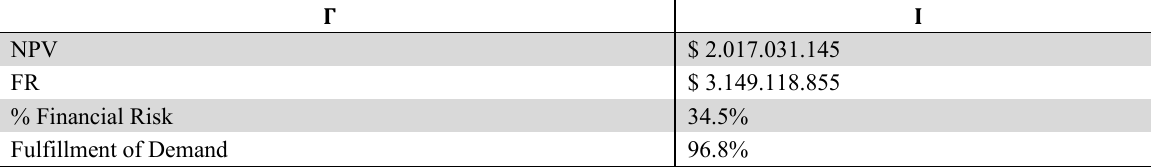
Optimal solution for each objective independently